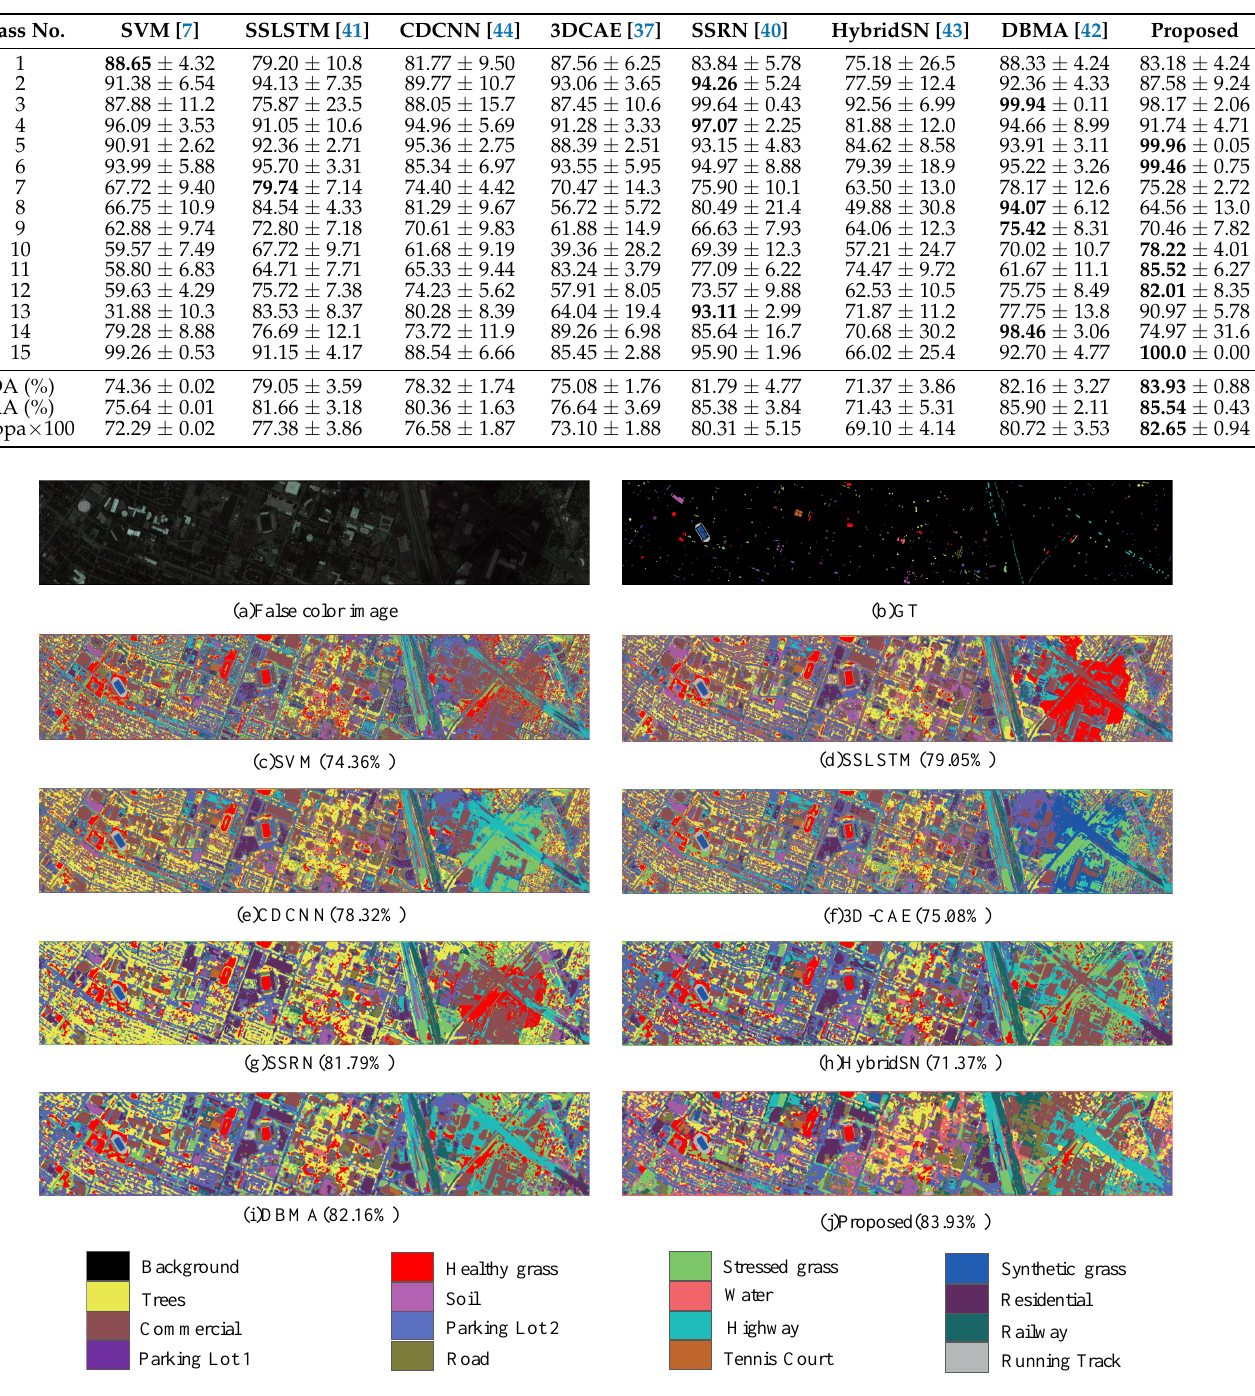
Table 8. Classification results on the Houston 2013 dataset with 10 labeled samples, including OA (%), AA (%) and Kappa × 100 in which the best results are denoted in bold.